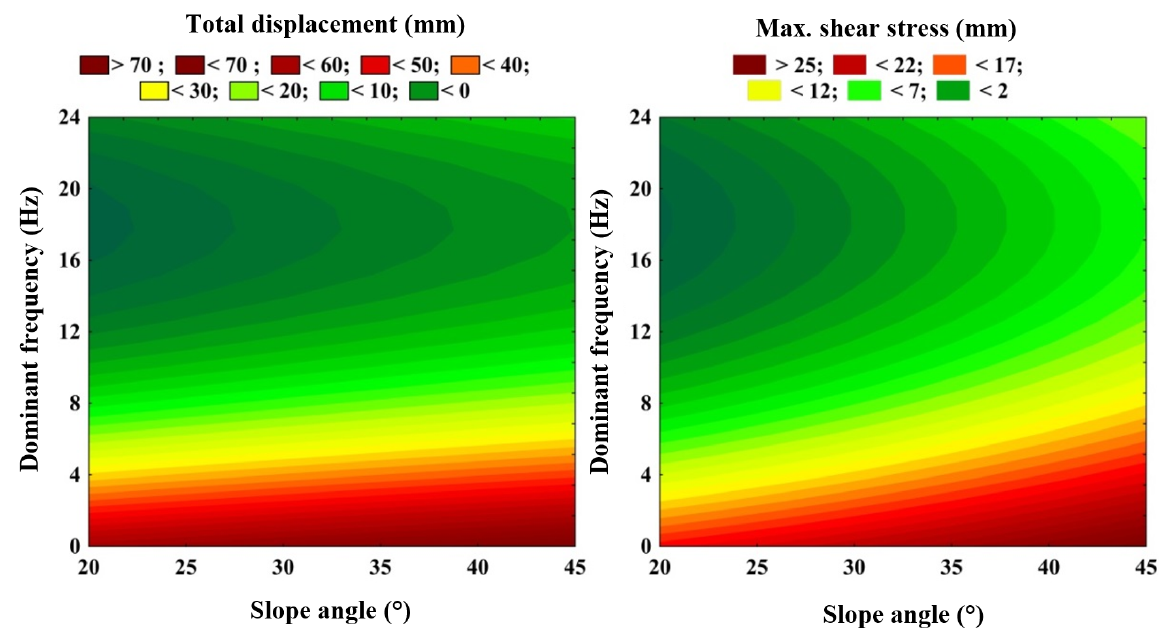
Figure 10: The RSM surface map of the relation between dominant frequency, slope angle and displacement (left) and shear stress (right) for scenarios in which the direction of seismic load is the same as the direction of slope